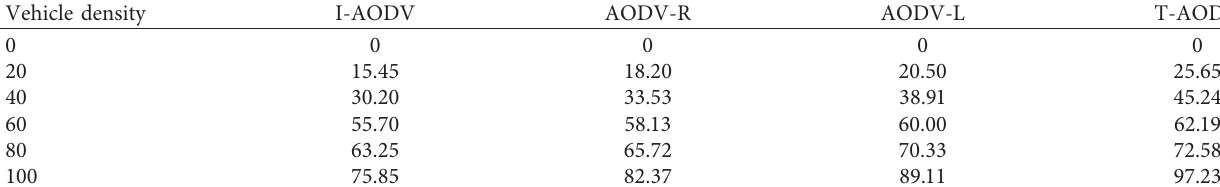
Table 2: Comparison of PDR for different existing techniques.